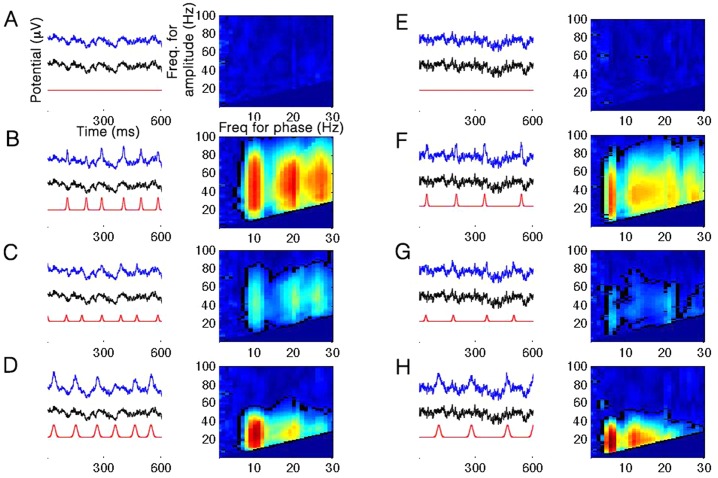
Examples of CFC in eight simulated signals.The plots on the left of each column depict a trace from the original (background) signal used for the simulation (black), the added Gaussian train (red), and the compound signal after adding the potentials (blue). The blue trace is therefore the sum of the black and the red ones. Note the temporal jitter in the Gaussian periodicity (i.e. variability of the inter-peak interval). The image on the right in each column shows the comodulogram for the compound signal (blue to red color scale corresponds to 0 to 1 in all panels). Clusters of significant CFC in the comodulograms are marked with a black outline (p<0.01). Note that values in the bottom triangle of each plot are not shown as CFC is invalid for frequencies-for-amplitude lower than the frequency-for-phase. The left column shows results for EEG-based simulations with a 100-ms mean inter-peak interval; the right column shows results for pink-noise-based simulations with a 166-ms mean inter-peak interval. It can be easily seen that the periodicity determines the frequency-for-phase of the CFC (10Hz and 6Hz, respectively), as well as its harmonics. A, D, the raw background traces with no added spikes. B, F, added spikes with an amplitude of 3 STDs and a width of 10 ms (full-width at half-maximum). C, G, Same as B,F but with an amplitude of 1.5 STDs. Note the diminished magnitude of the effect. D, H, Same as B,F but with a width of 20 ms. Note the lower frequency-for-amplitude range for which CFC occurs.